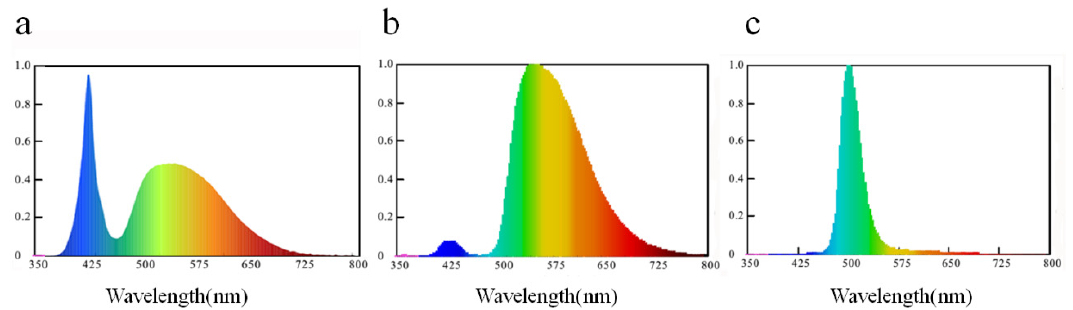
Figure 1. The spectra of the light emitting diode (LED) lights. ( a ) white LED lights; ( b ) green LED lights; ( c ) yellow LED